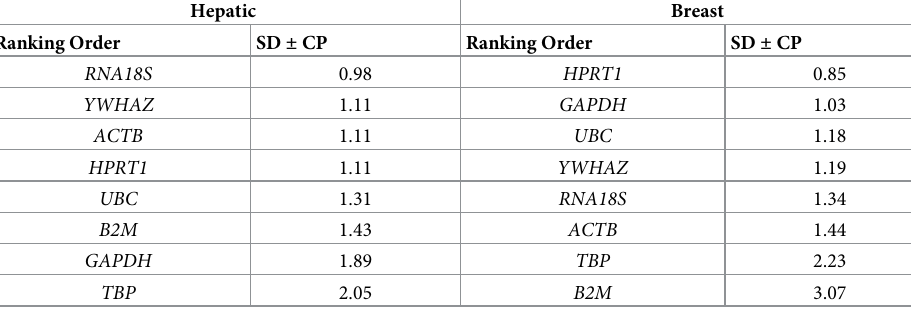
Table 5. Stability ranking order of nominee reference genes determined by BestKeeper algorithm.